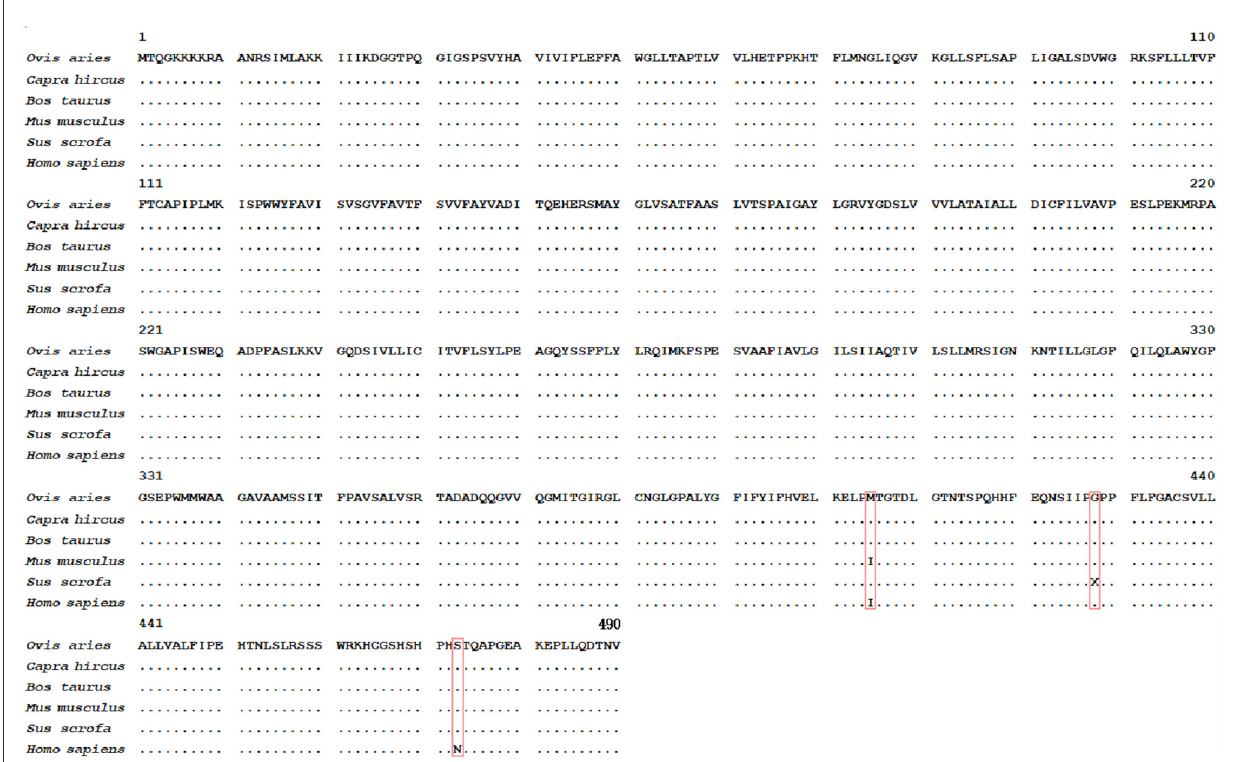
FIGURE1 Amino acid sequence alignment of HIAT1 in different mammalian species. The red boxes denote the parts of the sequence that are unable to be matched with the Ovis aries sequence. Note: • denotes the same amino acid.